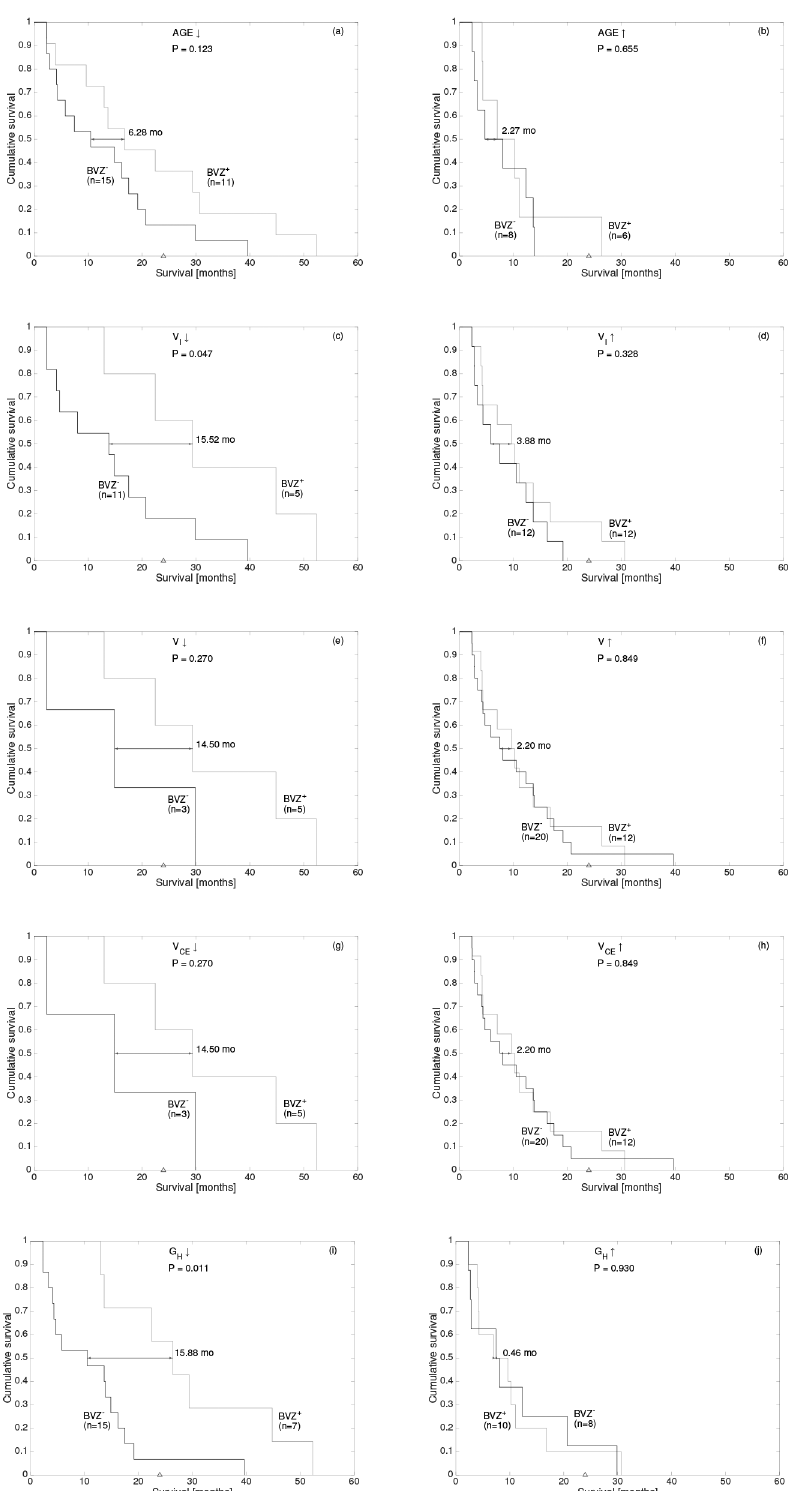
Fig 3. Kaplan-Meier curves comparing survival of subgroups of patients below or above the optimal thresholds shown in Table 4: (a,b) age, (c,d) V I , (e,f) V , (g,h) V CE and (i,j) G H . The median differences, p- values and number of patients in each subgroup are